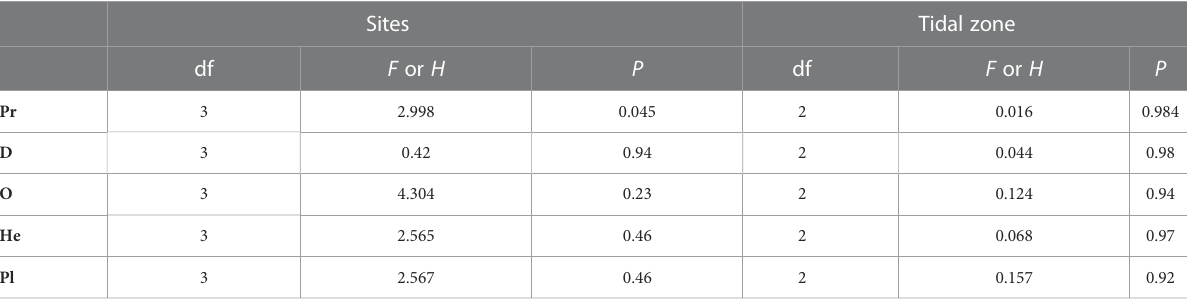
TABLE 6 Effect of study site and tidal zone on macrobenthos functional group biomass in the constructed intertidal oyster reef in Yangtze River Estuary during 2016-2017.